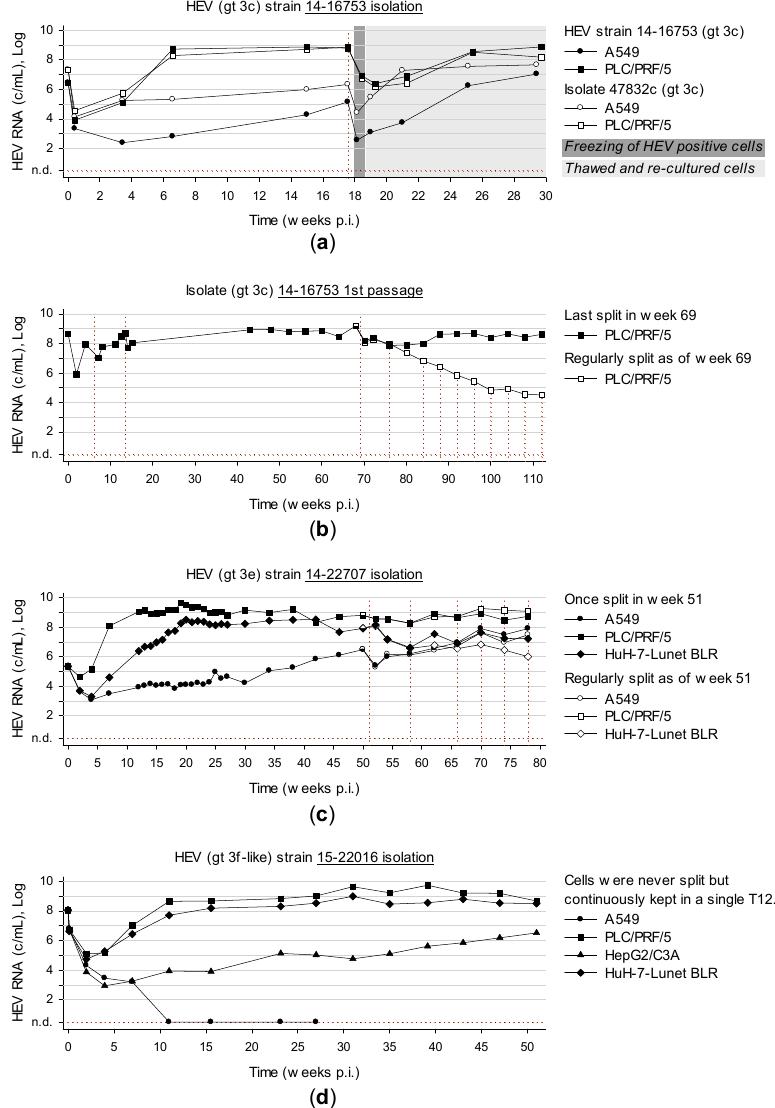
Figure 6. Long-term cultivation of cells persistently infected with HEV. ( a ) A549 and PLC/PRF/5 cells were inoculated with isolate 47832c and strain 14-16753-positive serum. After 123 dpi, cells were expanded, frozen and transferred to liquid nitrogen. Frozen cells were re-cultured and further followed up. ( b ) PLC/PRF/5 cells were inoculated with isolate 14-16753-positive PLC/PRF/5 supernatant. After 51 weeks, the effect of regular splitting on HEV load was investigated. ( c ) A549, PLC/PRF/5 and HuH-7-Lunet BLR cells were inoculated with strain 14-22707-positive serum and followed up for 1.5 years. ( d ) A549, PLC/PRF/5, HepC2/C3A and HuH-7-Lunet BLR cells were inoculated with serum positive for strain 15-22016 and followed up for one year. Culture supernatants were tested for HEV RNA. Vertical dotted lines mark passaging of cells. N.d., not detected; p.i., post inoculation.